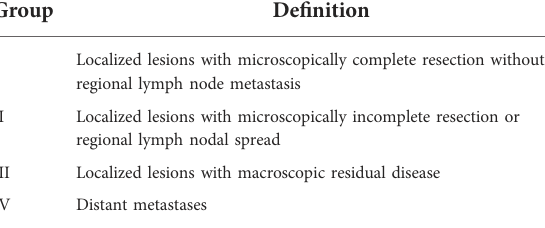
TABLE 1 Clinical group and treatment strategy for IFS in this study.